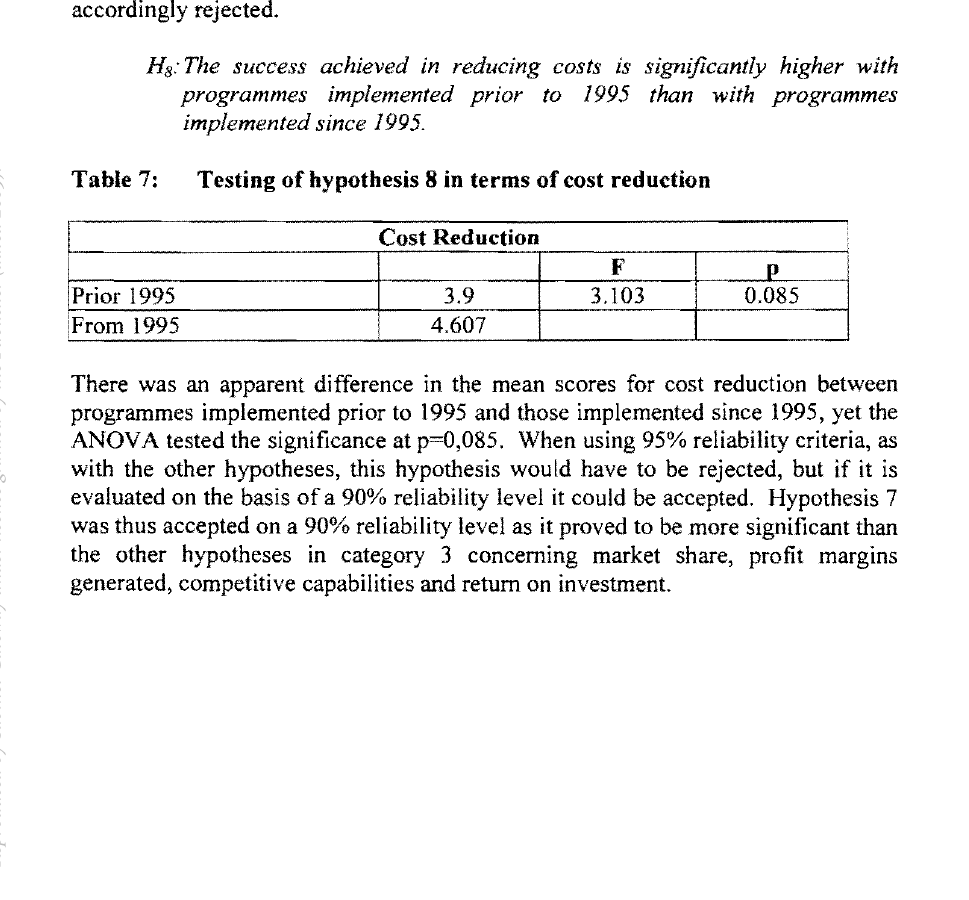
Testing of hypotheses 7 in terms of return on investment Return on Investment